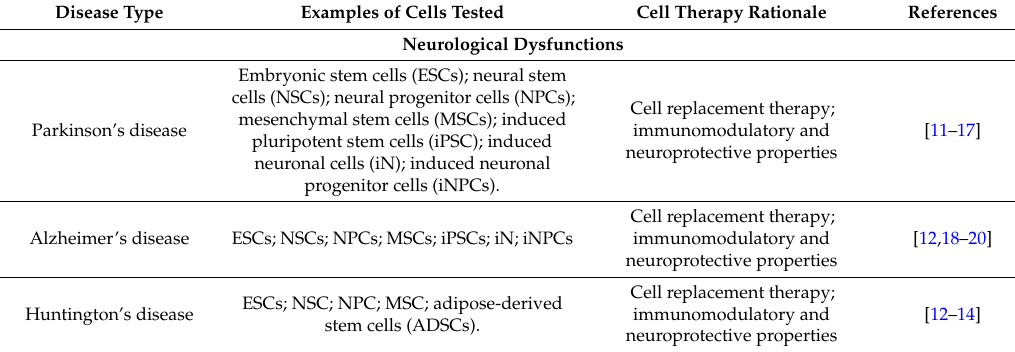
Table 1. Examples of the different types of cells evaluated for various